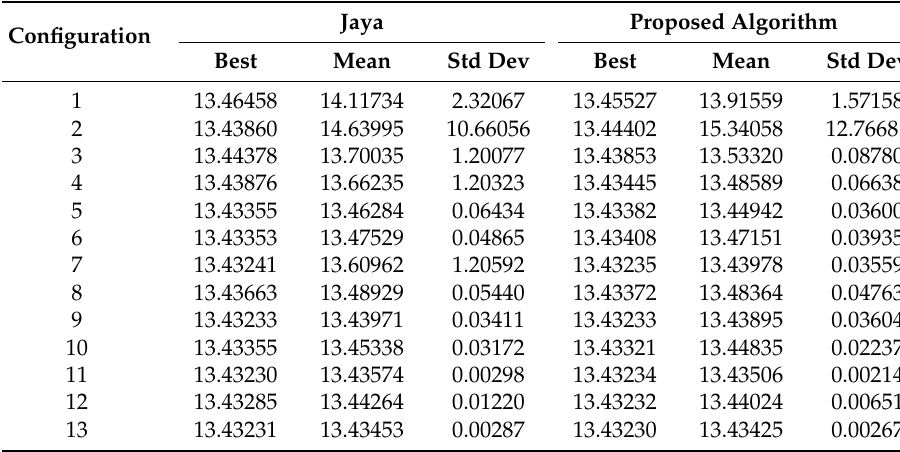
Table 4. Comparison of the solution quality between Jaya and the proposed method (each row corresponds to 100 independent runs). Jaya